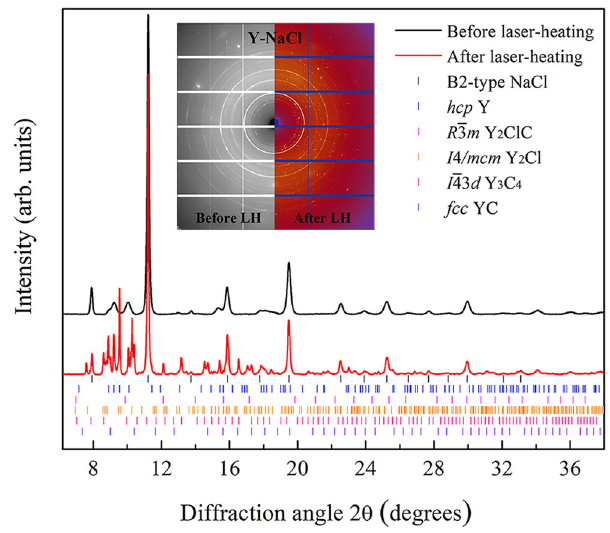
Fig. 1 Chemical reactions between yttrium and NaCl detected from X-ray diffraction. Powder X-ray diffraction patterns of the Y-NaCl sample before (black) and after (red) laser-heating at ~2000K and 41 GPa. Insert shows 2D XRD patterns of the same sample before and after laser heating. The previously known ( fcc -YC) and unknown (Y 2 Cl, Y 2 ClC, and Y 3 C 4 ) compounds were identi fi ed using single-crystal XRD data; the ticks here are added according to their calculated powder XRD